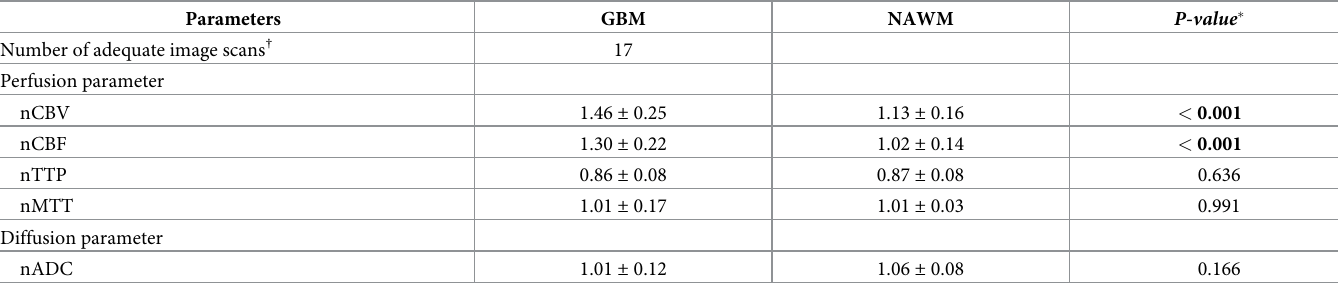
Table 3. Imaging characteristics of the canine GBM model.